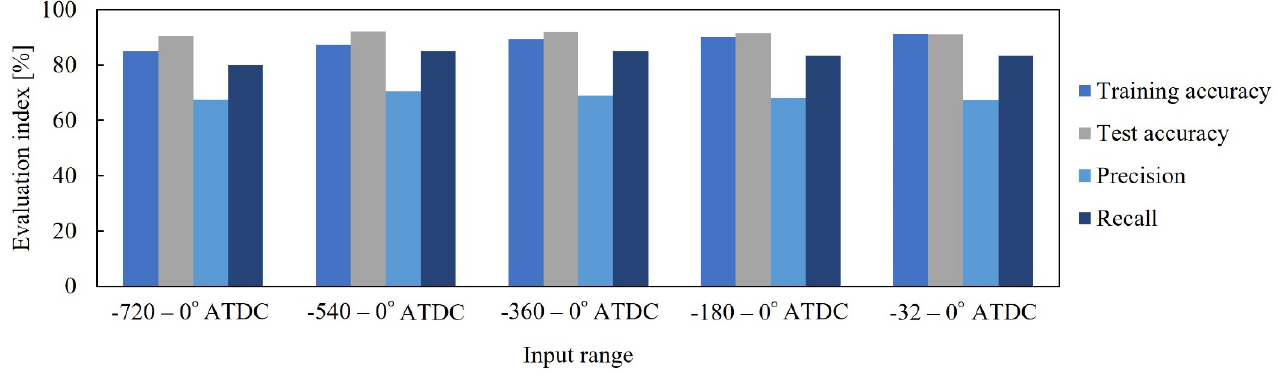
Figure 6. Effects of changing the start CA on prediction.